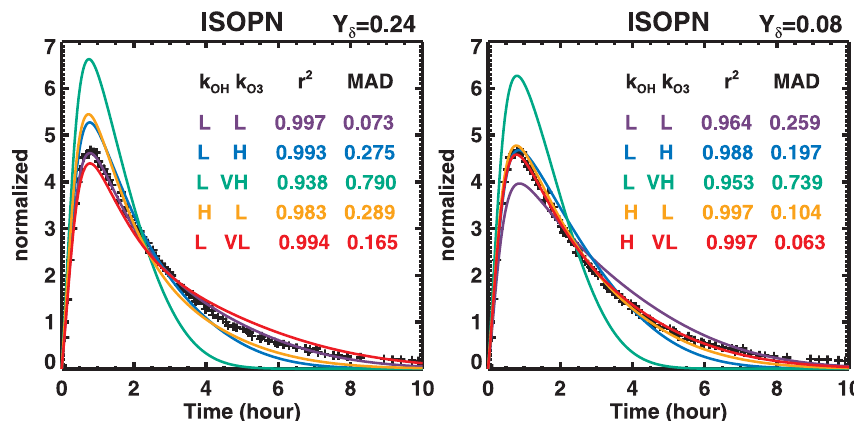
Fig. 4. Calculated mixing ratios of the normalized sum of first-generation isoprene nitrates weighted by their calibration factors in the experiment of Paulot et al. (2009). The reported measurements are shown as black crosses. The assumed nitrate yield in the reaction of δ -hydroxyperoxy radicals from isoprene is either 0.24 (left panel) or 0.08 (right). The model runs differ in the assumed reaction rates of isoprene β -hydroxy-nitrates with OH and O 3 . The values for k OH are 1.3 × 10 − 11 (L) and 2.2 × 10 − 11 (H) cm 3 molec. − 1 s − 1 . The values for k O are 0.5 × 10 − 17 (VL), 10 − 17 (L), 3 × 10 − 17 (H) and 10.6 × 10 − 17 (VH) cm 3 molec. − 1 s − 1 . The (squared) Pearson correlation 3 coefficients and mean absolute deviations (MAD) are also indicated.